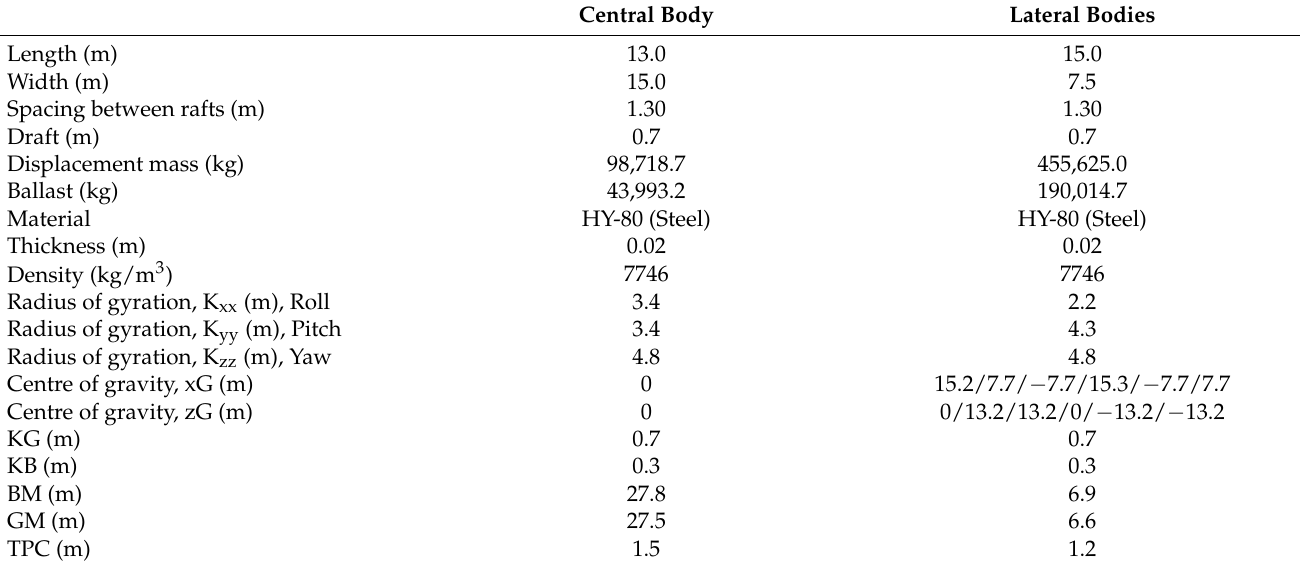
Figure 2. Nenuphar WEC design (perspective view and top view). Table 1. Main parameters of initially designed Nenuphar in full